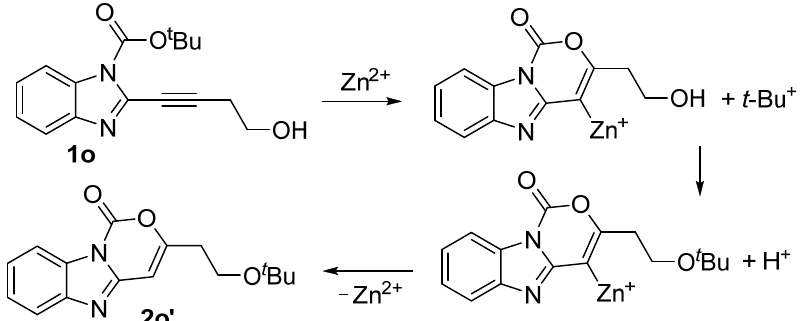
Figure 3. Molecular structure of 3-butyl-8-nitro-1 H -benzo[4,5]imidazo[1,2- c ][1,3]oxazin-1-one 2f . Color legend: carbon (light grey), hydrogen (white), oxygen (red), nitrogen (blue) (CCDC 2050711).